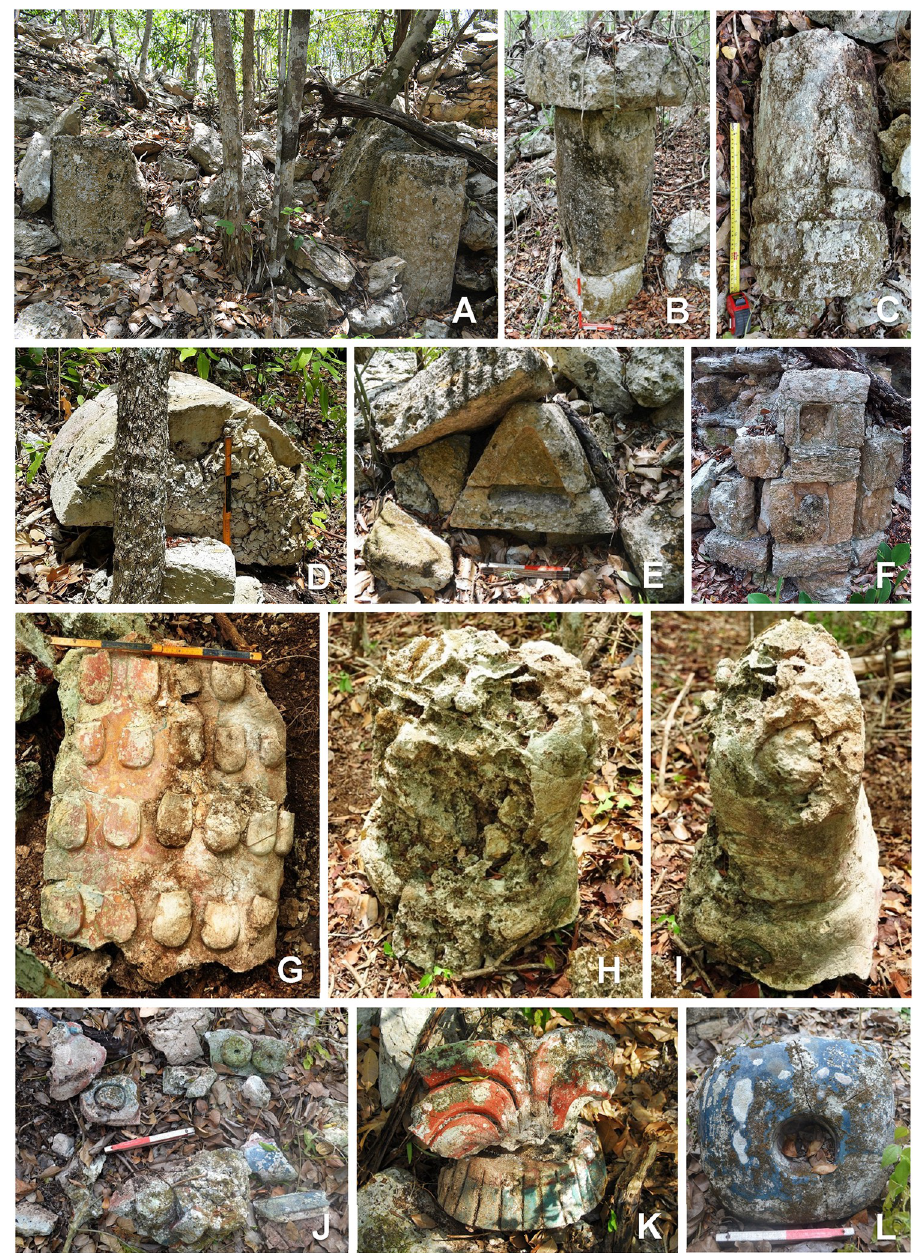
Fig 8. Architectural characteristics: columns in group D23-b (A); column with capital in group E10-d (B); decorated colonnette in group F25-a (C); fragment of masonry column in group F15-a (D); decorative element in group D17-a (E); decorative element in group E19-b (F); fragment of painted stucco decoration in group F15-c (G); human torso covered with painted stucco in group F15-c (H, I; for a similar torso found at Dzibanmac south of Xpujil, see [32]); fragments of painted stucco decoration in group K16-a (J, K,